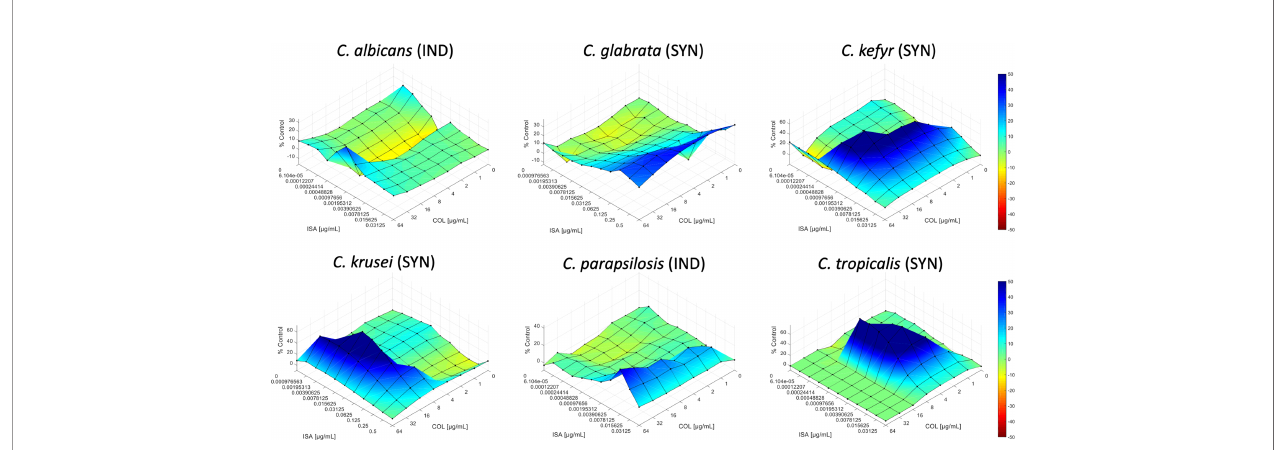
FIGURE 1 | Synergy distribution for the combination of isavuconazole with colistin against Candida albicans V2105529, Candida glabrata U2106602, Candida kefyr V2108462, Candida krusei N2102435, Candida parapsilosis V2105056, and Candida tropicalis N2102715. The mode of interaction was de fi ned based on the SUM- SYN-ANT metric. IND, indifference; SYN, synergy.